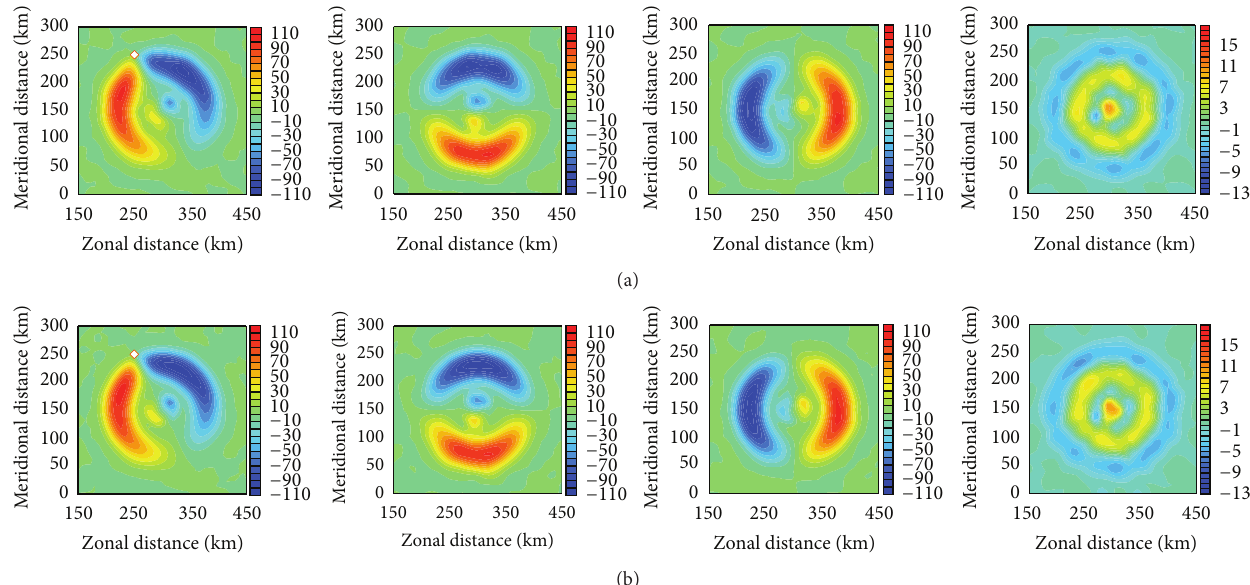
Figure 3: (a) and (b) are similar to Figures 2(b) and 2(c) but with the conventional data substituted by moderate conventional data (unit: m/s).